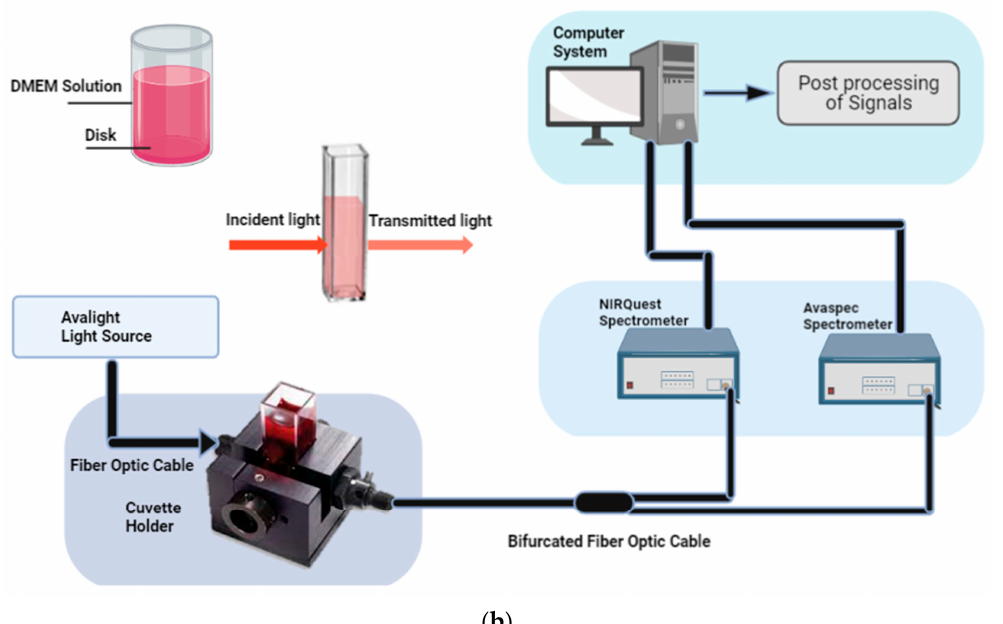
Figure 2. The experiment set up for the optical measurements in this paper: ( a ) Refection-type measurement where the source (S) and detector (D) are on the same side of the medium. It uses the optical probe given in Figure 1. This is the experimental setup used for the in vivo experiment [21]; ( b ) transmission-type measurement where the medium is taken in a cuvette, which is placed in the holder. This is the experimental setup used for in vitro experimentation [25].